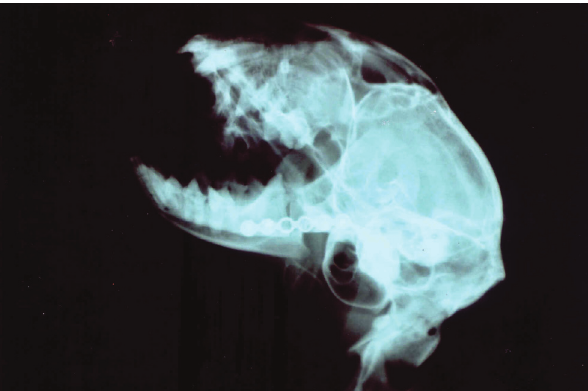
FIGURE 3 - Radiograph in oblique lateral projection taken 1 week after surgery shows the segmental defect filled with autogoneous bone graft. Cat 5 of Group 1.